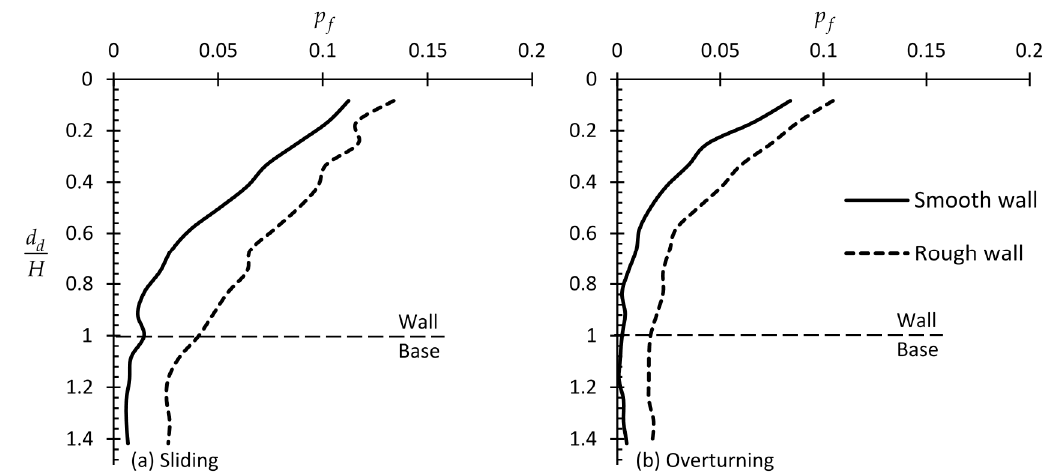
Figure 13. p f − d d / H curves for the rough and smooth wall for the ( a ) sliding and ( b ) overturning modes of failure. Additionally, θ / H = 8.3 and x / H = 0.5.